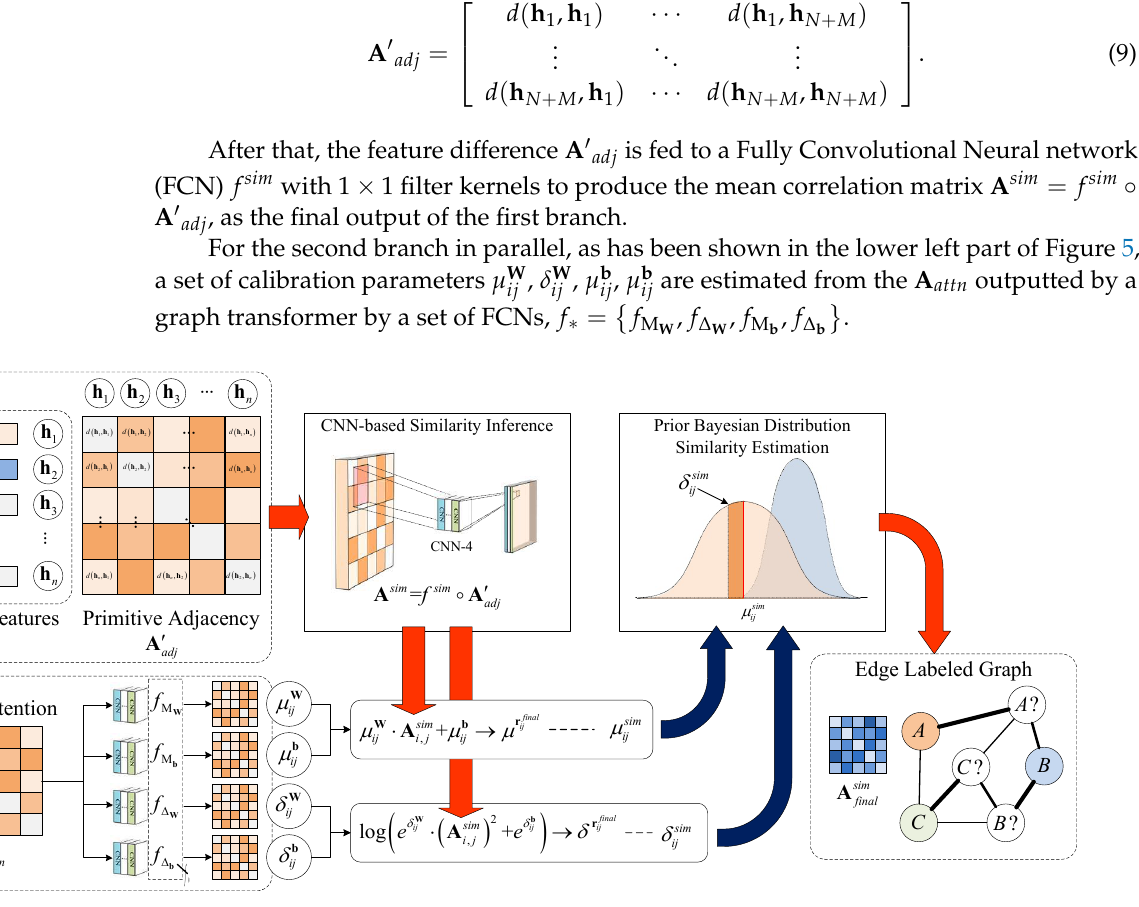
Figure 5. Illustration of the calculation workflow in the Bayesian graph labeling